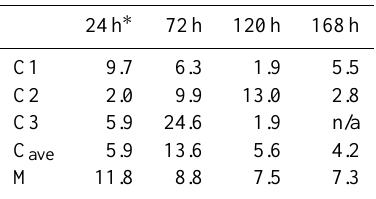
Table 4. Measured and modelled export flux of inorganic particles (mgm − 2 d − 1 ) under control conditions, calculated assuming an Al content of 7.7%. C1–C3 stand for the triplicate CONTROL-meso, C ave for the mean of C1–C3 and M for model results. Numbers are averaged fluxes in the time periods after dust addition in DUST- meso.